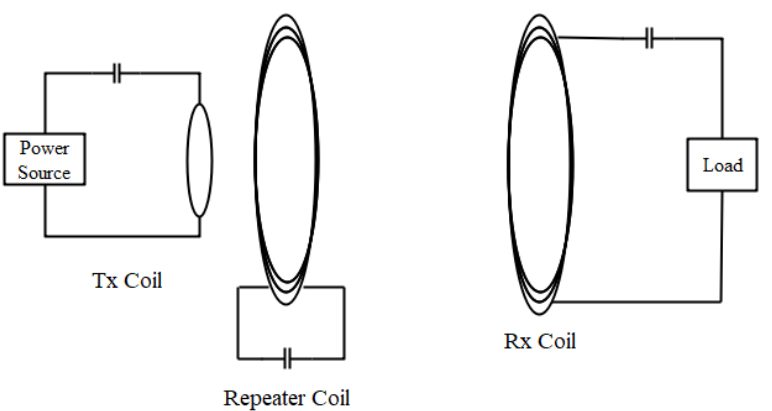
Figure 1. Basic structure of a three-coil IPT system.